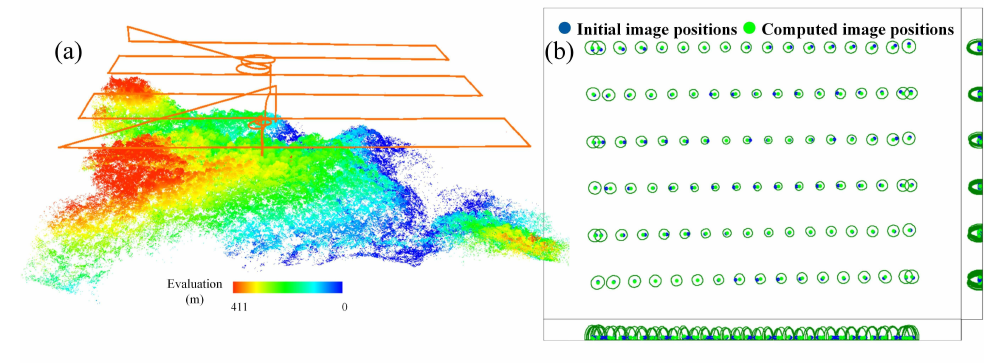
Figure 3. ( a ) Three-dimensional terrain display. The orange line shows the UAV flight trajectory. ( b ) Location uncertainty assessment